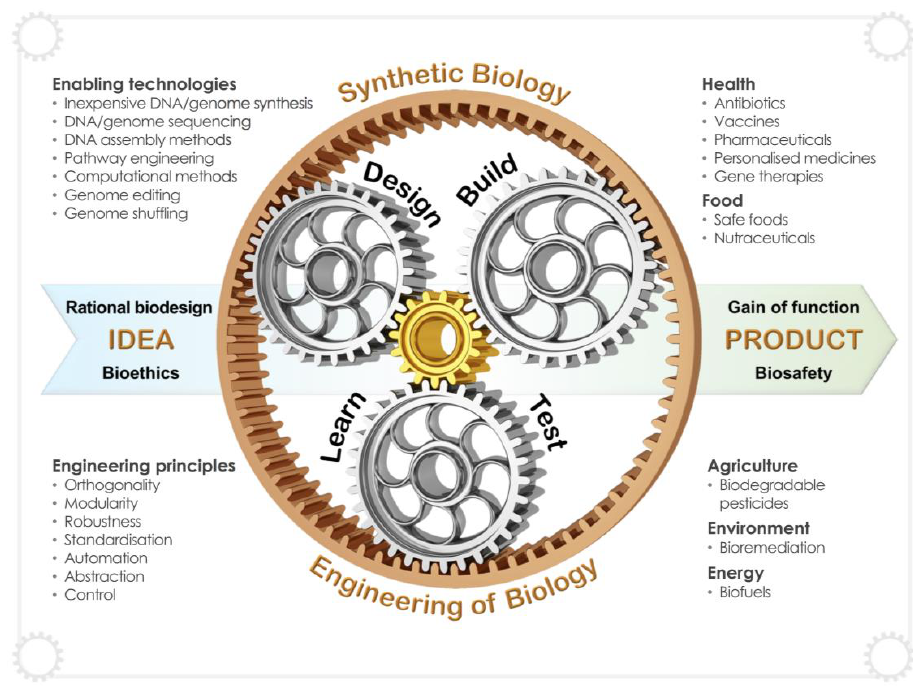
Figure 3. Synthetic biology entails the engineering of biology, incorporating enabling technologies and enabling approaches framed around rational engineering principles. As opposed to classical biological tinkering, synthetic biology can rapidly translate an idea into a product or application through the recursive Design-Build-Test-Learn cycle.